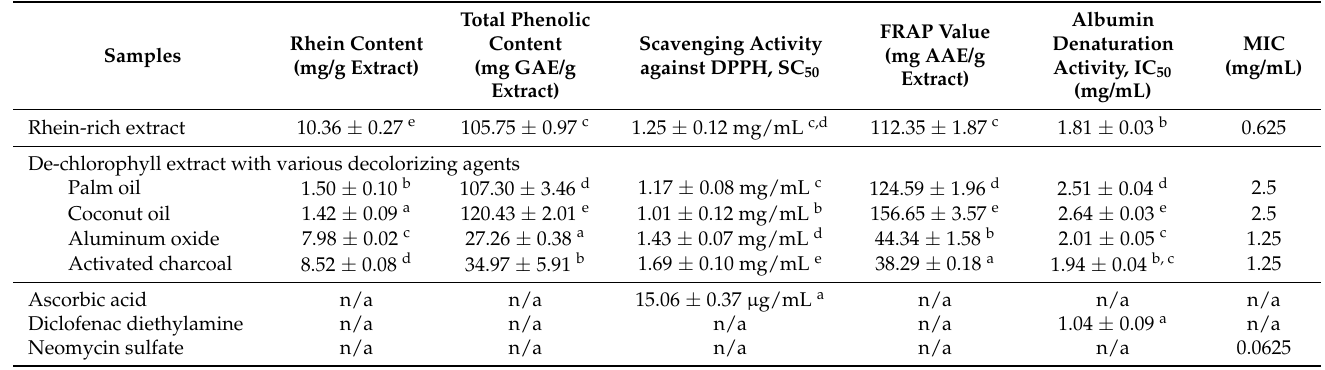
Table 11. Rhein content, total phenolic content, antioxidant activity, anti-inflammatory activity and antibacterial activity against S. aureus of rhein-rich extract and its de-chlorophyll